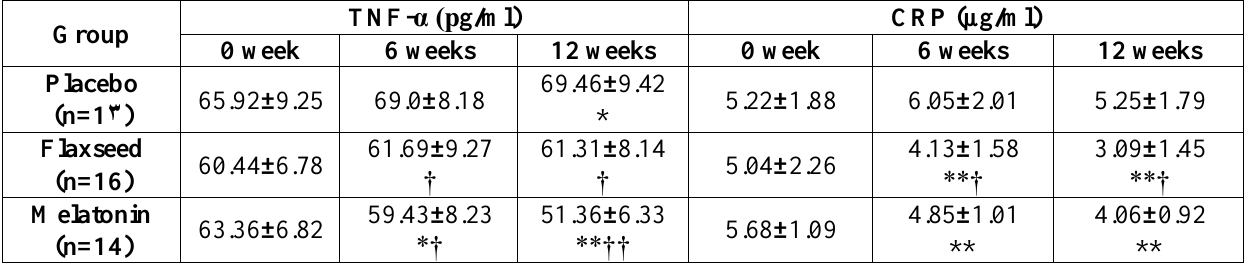
Table (3): Inflammatory markers in each group at varied treatment